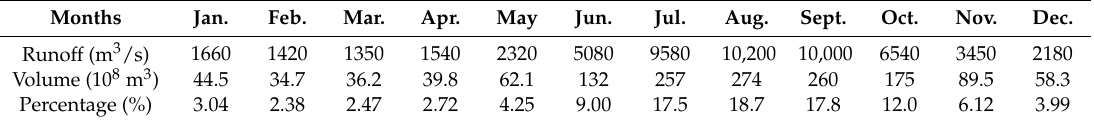
Table 2. Runoff and its percentage for each month at the Pingshan gauging